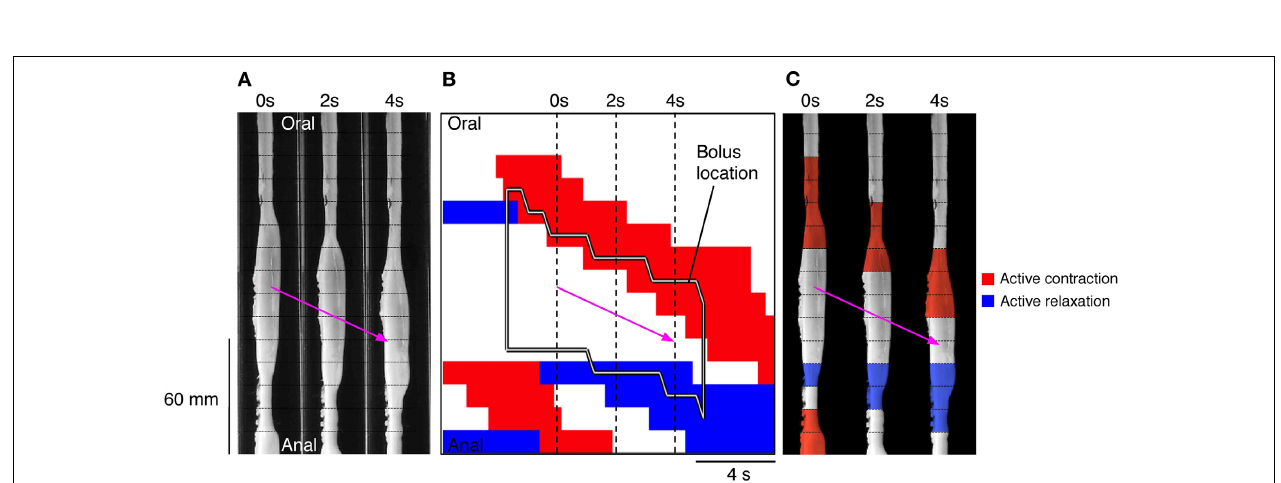
black line in (A,E) indicates the mean dilation at each point in time along the 12cm region of colon and the thickness of the line indicates the 95% confidence interval. The thin gray lines indicated the standard deviation. The mean dilation immediately prior to the active propagating contractions is 2.7mm which is significantly greater ( P < 0 . 0001) than mean dilation prior to the active non-propagating contractions (1.6mm). The right hand side of figure shows the relation that exists between the active states (contraction red and relaxation blue) and the active propagating (C,D) and non-propagating (G,H) contractions. Note that there is a significantly ( P < 0 . 005) degree of active relaxation associated with active propagating contractions in comparison to active non-propagating contractions (C,G) .